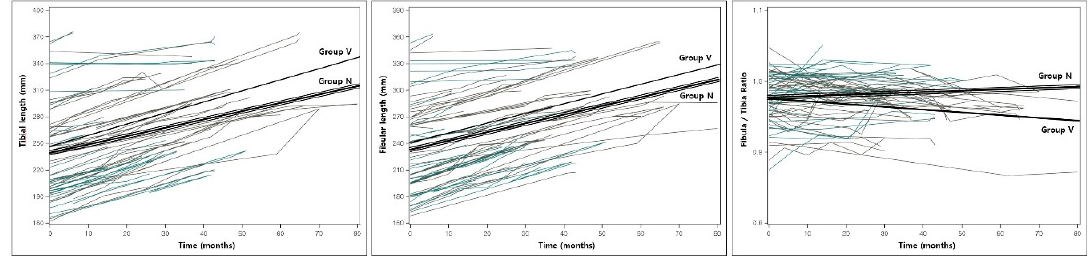
Figure 2. The spaghetti plot and estimated slope in the tibial, fibular length and fibula / tibia ratio of groups N and V. The solid line indicates the estimated slope of group V. and triple lines indicate the estimated slope of group N. No significant di ff erence was noted in fibular length, and there was a significant di ff erence in slope between group N and group V in tibial length and fibula / tibia